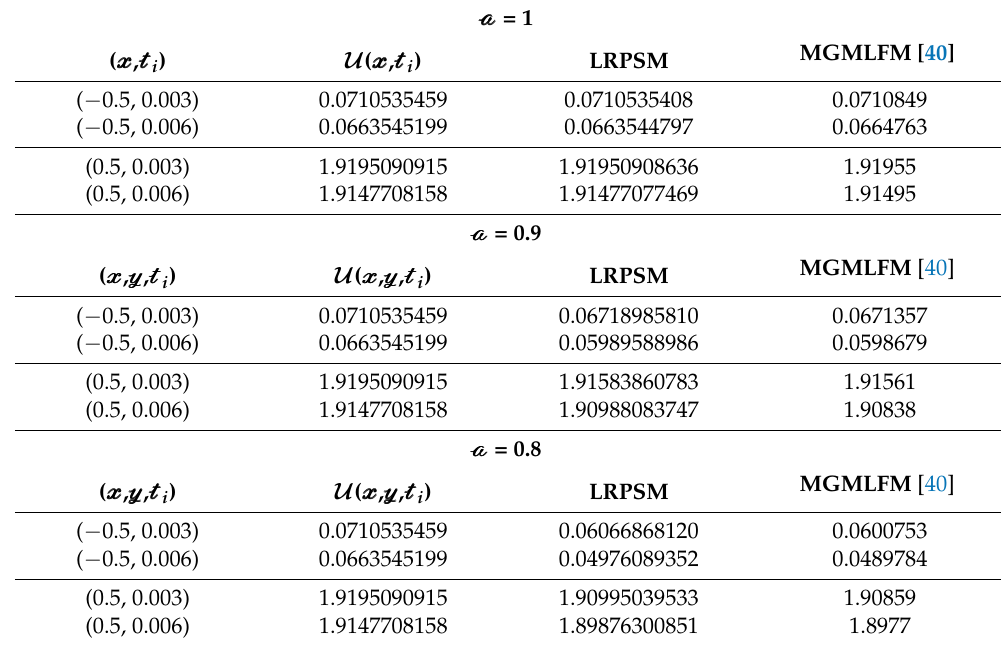
Table 8. Numerical comparisons for Example 1 at different values of 𝓍 , 𝒶 , and 𝓉 for the function U .